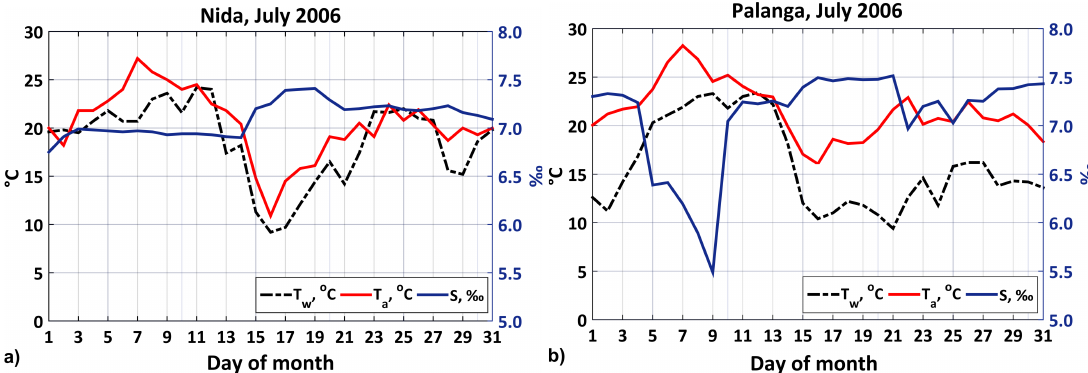
Figure 13. Sea water temperature (T w ), air temperature (T a ), and salinity (S) changes recorded at the Nida and Palanga coastal stations in July 2006.